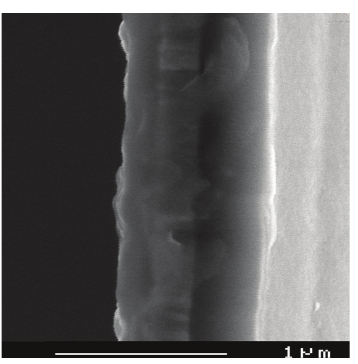
Figure 5: Cross-sectional SEM micrograph of glass/ITO/PEDOT: PSS/P3HT 0.3 :CuPc 0.3 :C60 0.4